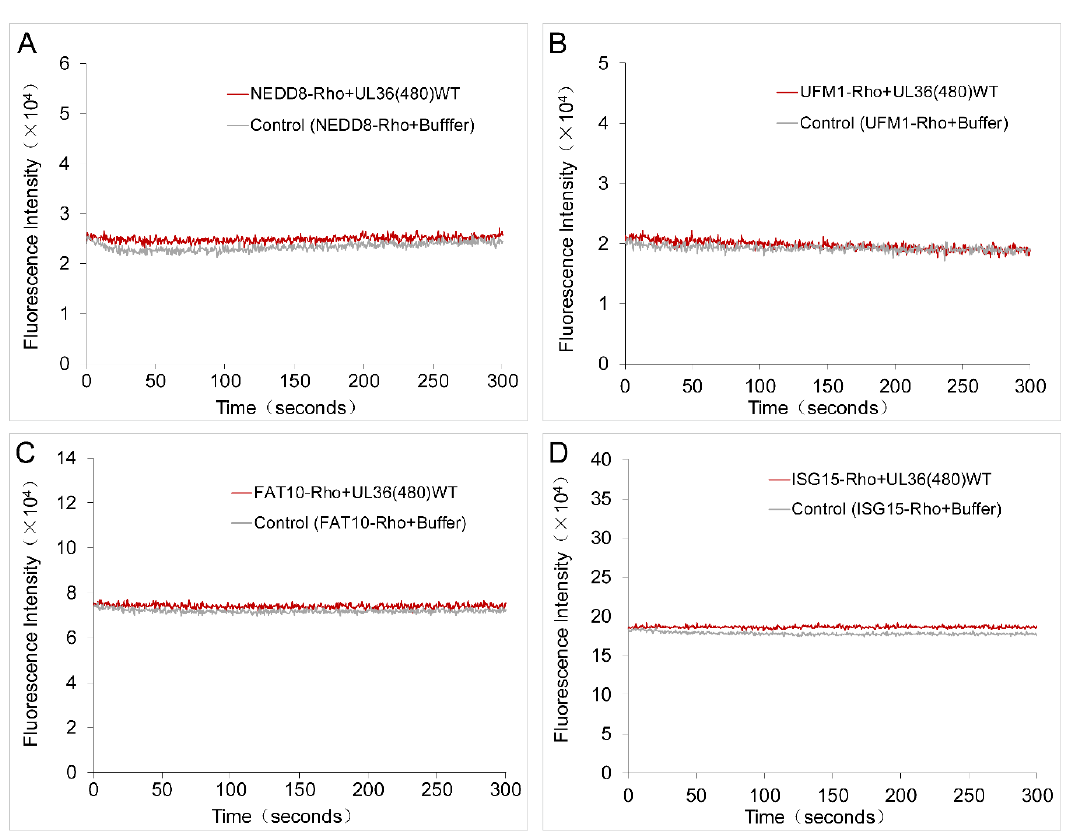
Figure 5. Characterization of hydrolysis activity of UL36(480)WT on rhodamine-conjugated Ub-like substrates. (A − D) , fluorescence traces of rhodamine released on the hydrolysis of rhodamine-conjugated NEDD8 (A) , UFM1 (B) , FAT10 (C), and ISG15 (D) substrates by wild type UL36(480), UL36(480)WT. Control, the group contained an equal volume of buffer but no UL36(480)WT.